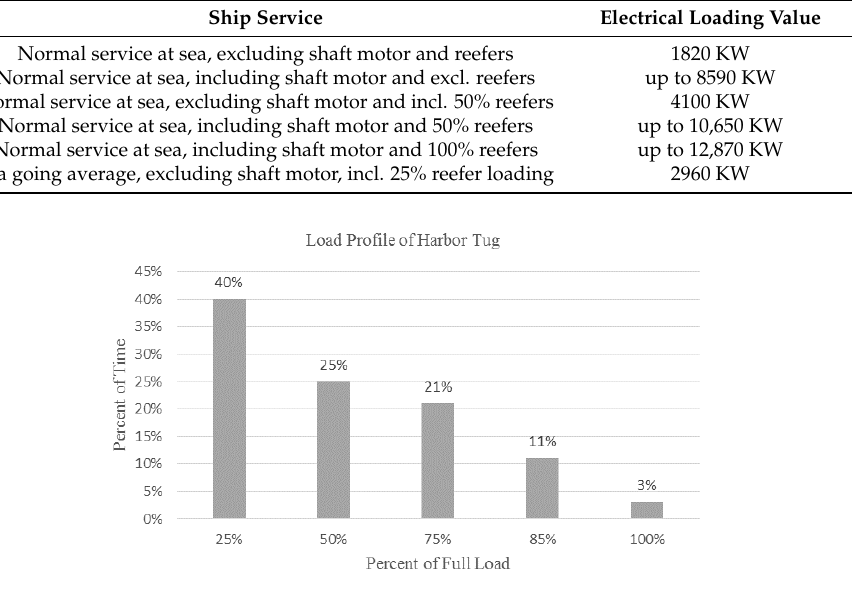
Figure 4. Load profile of a typical harbor tug.